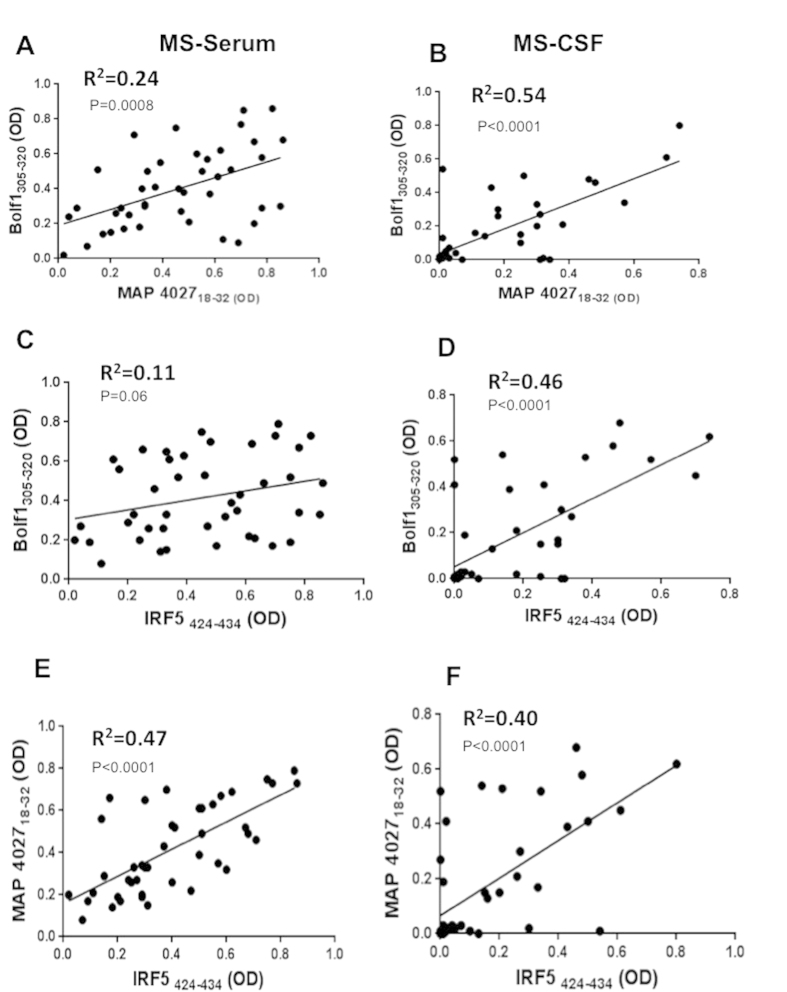
Scatter plot showing the correlations between BOLF1305–320 with MAP_402718–32 in serum (A) in CSF (B). BOLF1305–320, MAP_402718–32 with IRF5424–434 in serum (C,E) in CSF (D,F) in MS patients. Pearson’s correlation was calculated by Graph Pad 6.